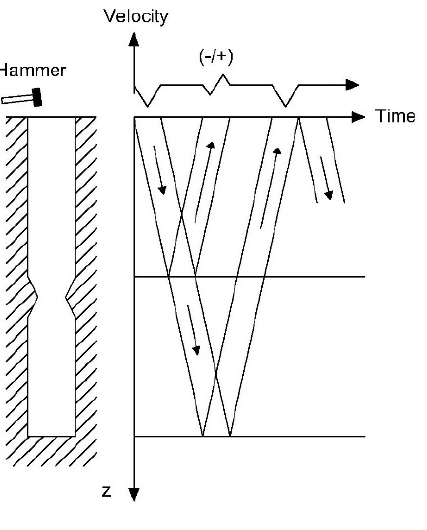
Figure 4. Pile with neck defect.